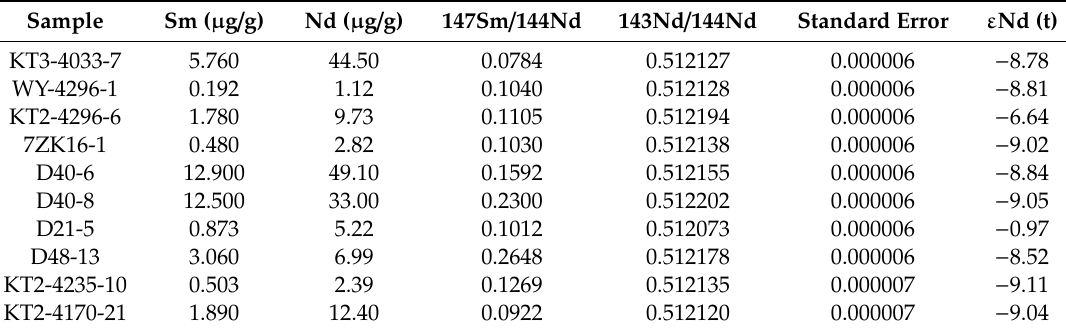
Table 6. Sm–Nd concentrations and isotopic ratios of the garnet from the Hongshan deposit.